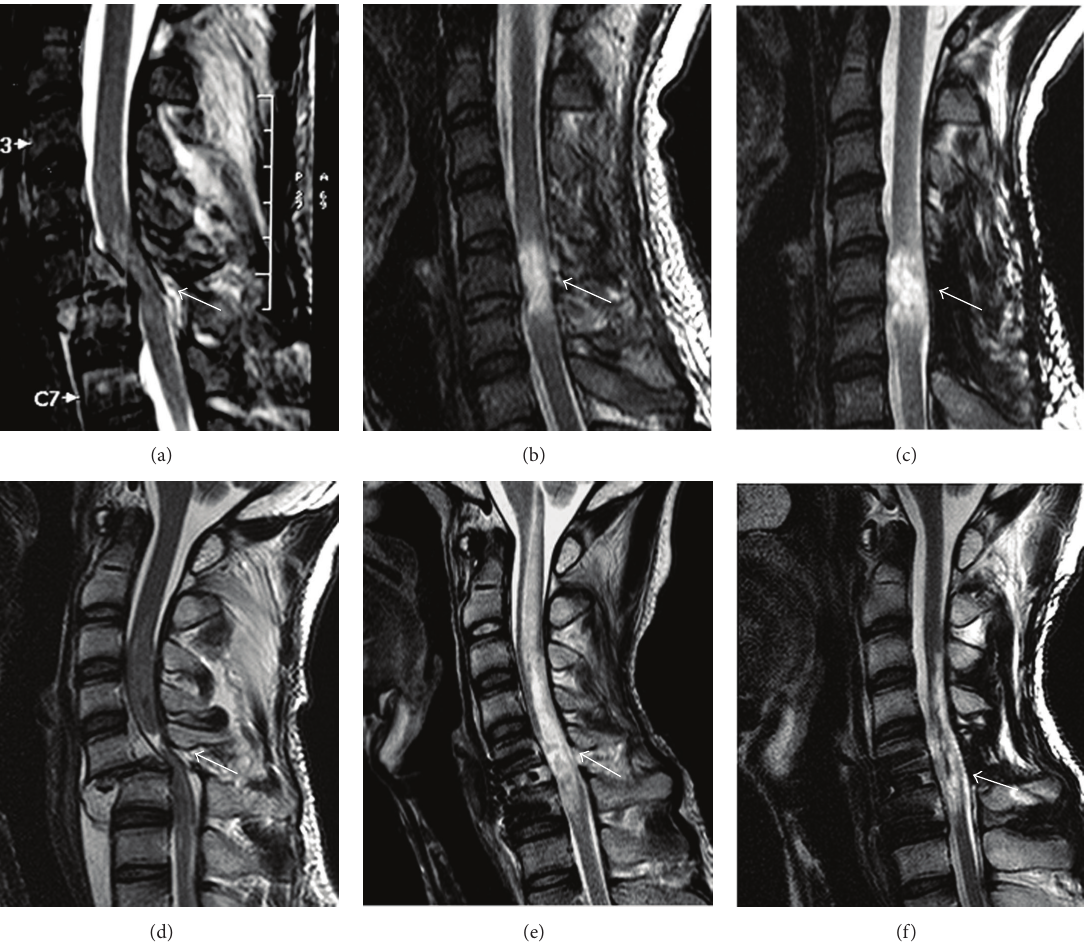
Figure 5: Sagittal T2W MRI scan of two SCI patients (upper panel: patient 8; lower panel: patient 15) at the time of injury (a, d), before transplantation as a baseline (b, e), and 1 year after transplantation (c, f). Follow-up findings showed progressive myelomalacic change at the site of cell transplantation (c) or myelomalacia and atrophy of the cord (f) in cell implantation areas. The white arrows mark the site of